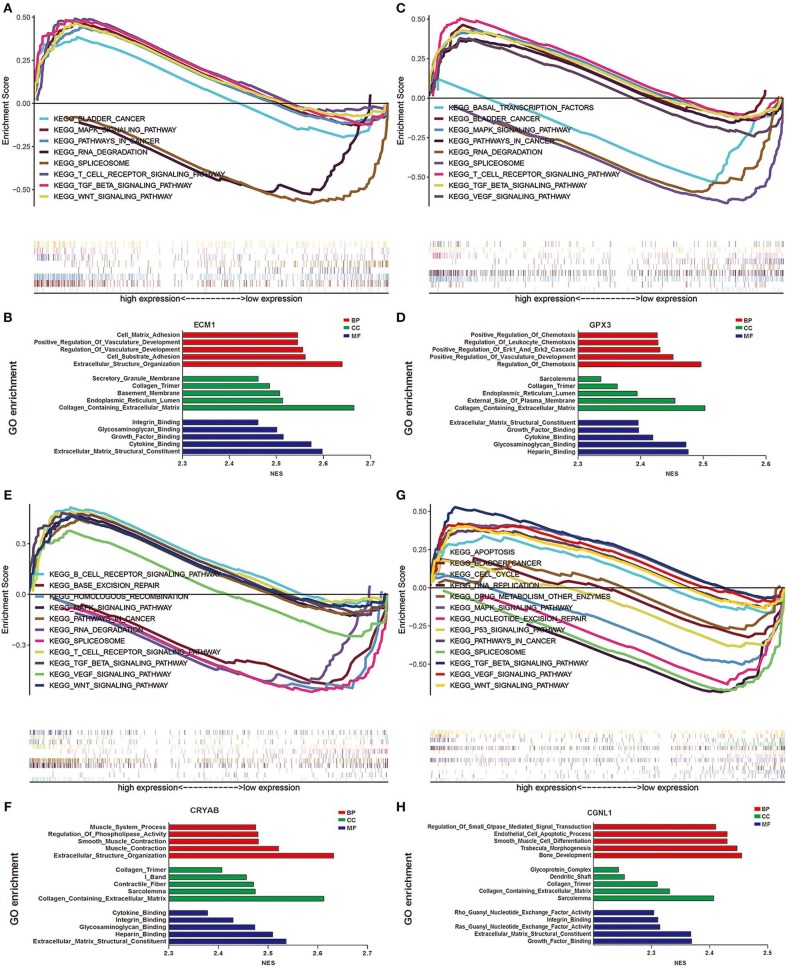
Gene set enrichment analysis (GSEA) analysis of ECM1, GPX3, CRYAB, and CGNL1. (A) KEGG pathway enrichment for ECM1; (B) Gene Ontology (GO) enrichment for ECM1; (C) KEGG pathway enrichment for GPX3; (D) GO enrichment for GPX3; (E) KEGG pathway enrichment for CRYAB; (F) GO enrichment for CRYAB; (G) KEGG pathway enrichment for CGNL1; and (H) GO enrichment for CGNL1. BP, biological process; CC, cell component; MF, molecular function; NES, Normalized Enrichment Score.